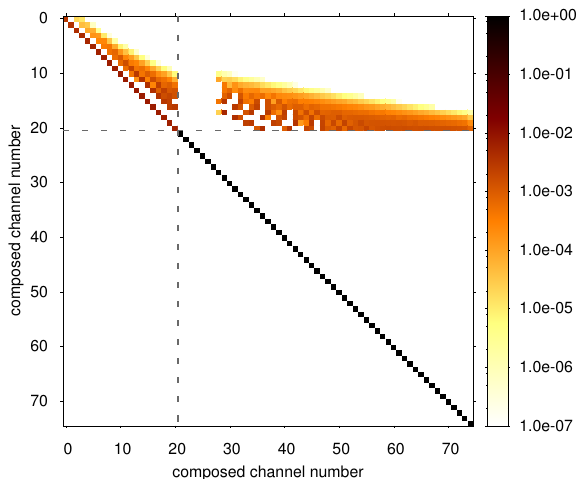
Fig. 4a: Example of the error propagation of a mobility par- ticle size spectrometer PNSD, Hohenpeissenberg, 23.02.12, Fig. 5a. Visualization of the multiple-charge matrix using only mo- bility particle size spectrometer data. one-hour average 0:00 - 1:00, EPMD (black) in plain con- centration (secondary y-axis) and PNSD (red). The fictive relative error of the results increases for sampling points in- Fig. 5a: Visualization of the multiple charge matrix using fluenced by multiple charge correction from 10% to 15% only mobility particle size spectrometer data.